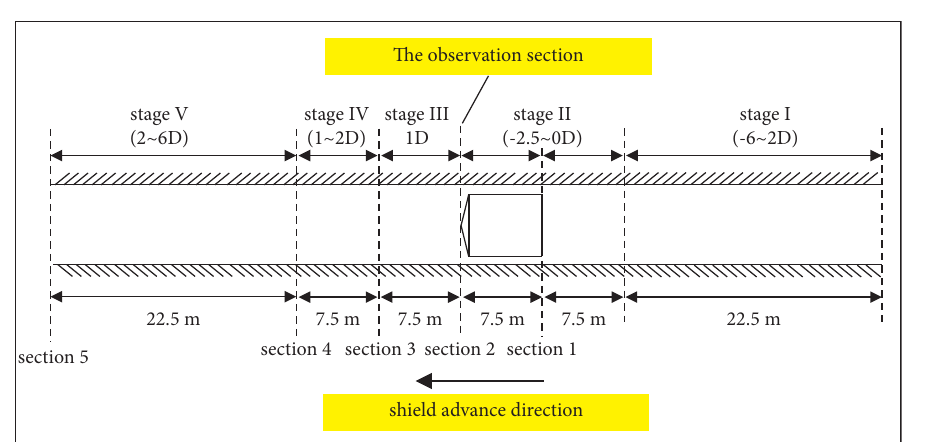
Figure 22: Simulation diagram of shield advance process.